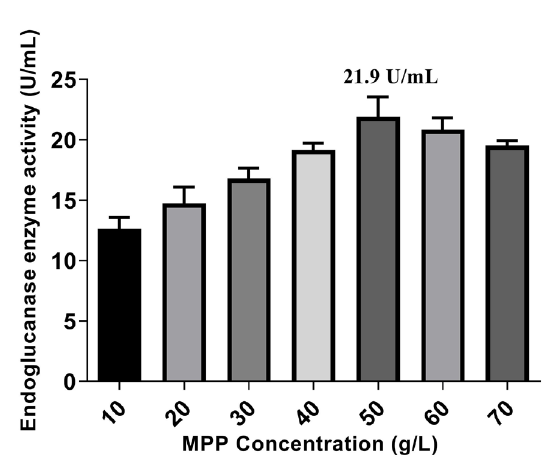
Figure 4. Effects of MPP concentration on the endoglucanase enzyme activity. Culture condions: 0.5 g/L yeast extract, Temperature 35°C, initial pH 8.0, and incubation time 48